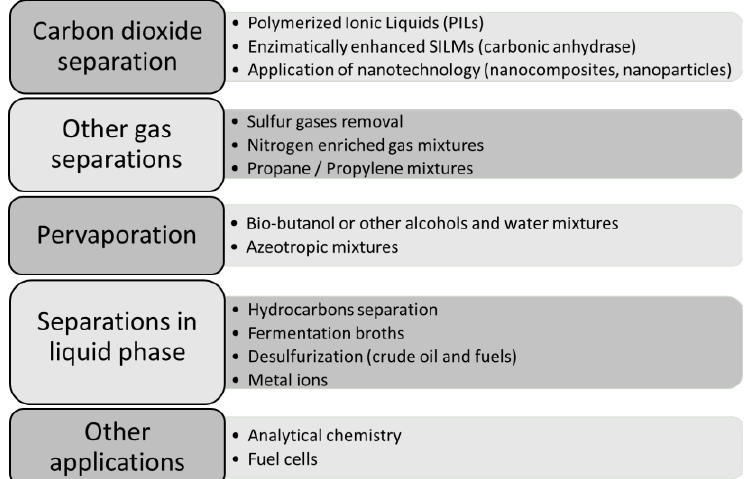
Figure 4. Main applications and hot current trends for SILMs.